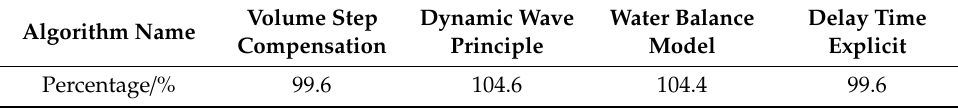
Table 4. Percentage of actual compensation storage to target compensation